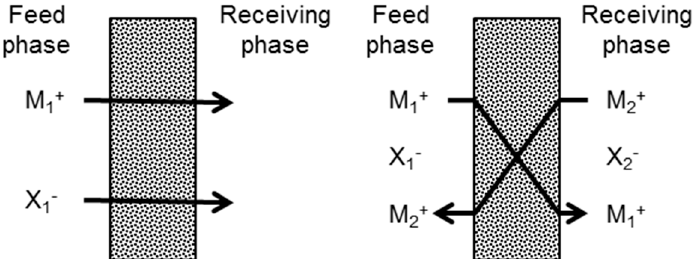
Figure 1. Scheme of the transport across a PIM for a cation (M n+ ) and an anion (X n − ): co-transport of a counter-ion ( left ); and ion-exchange ( right ).